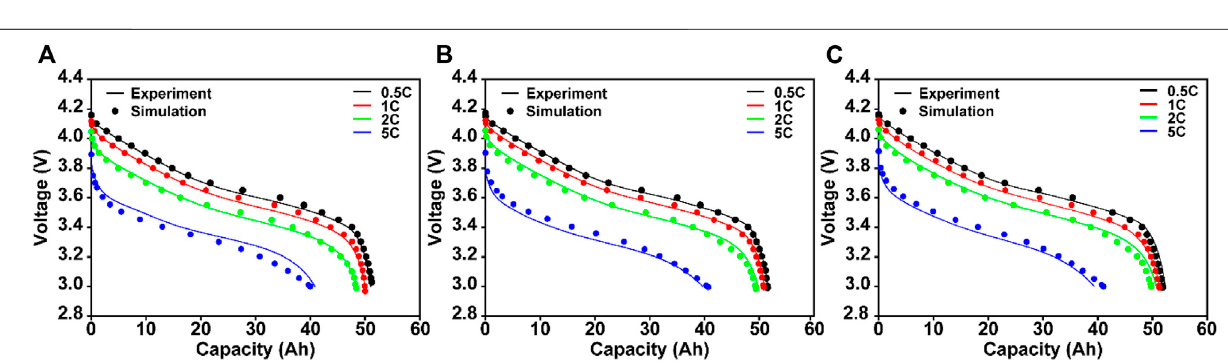
Frontiers in Materials |